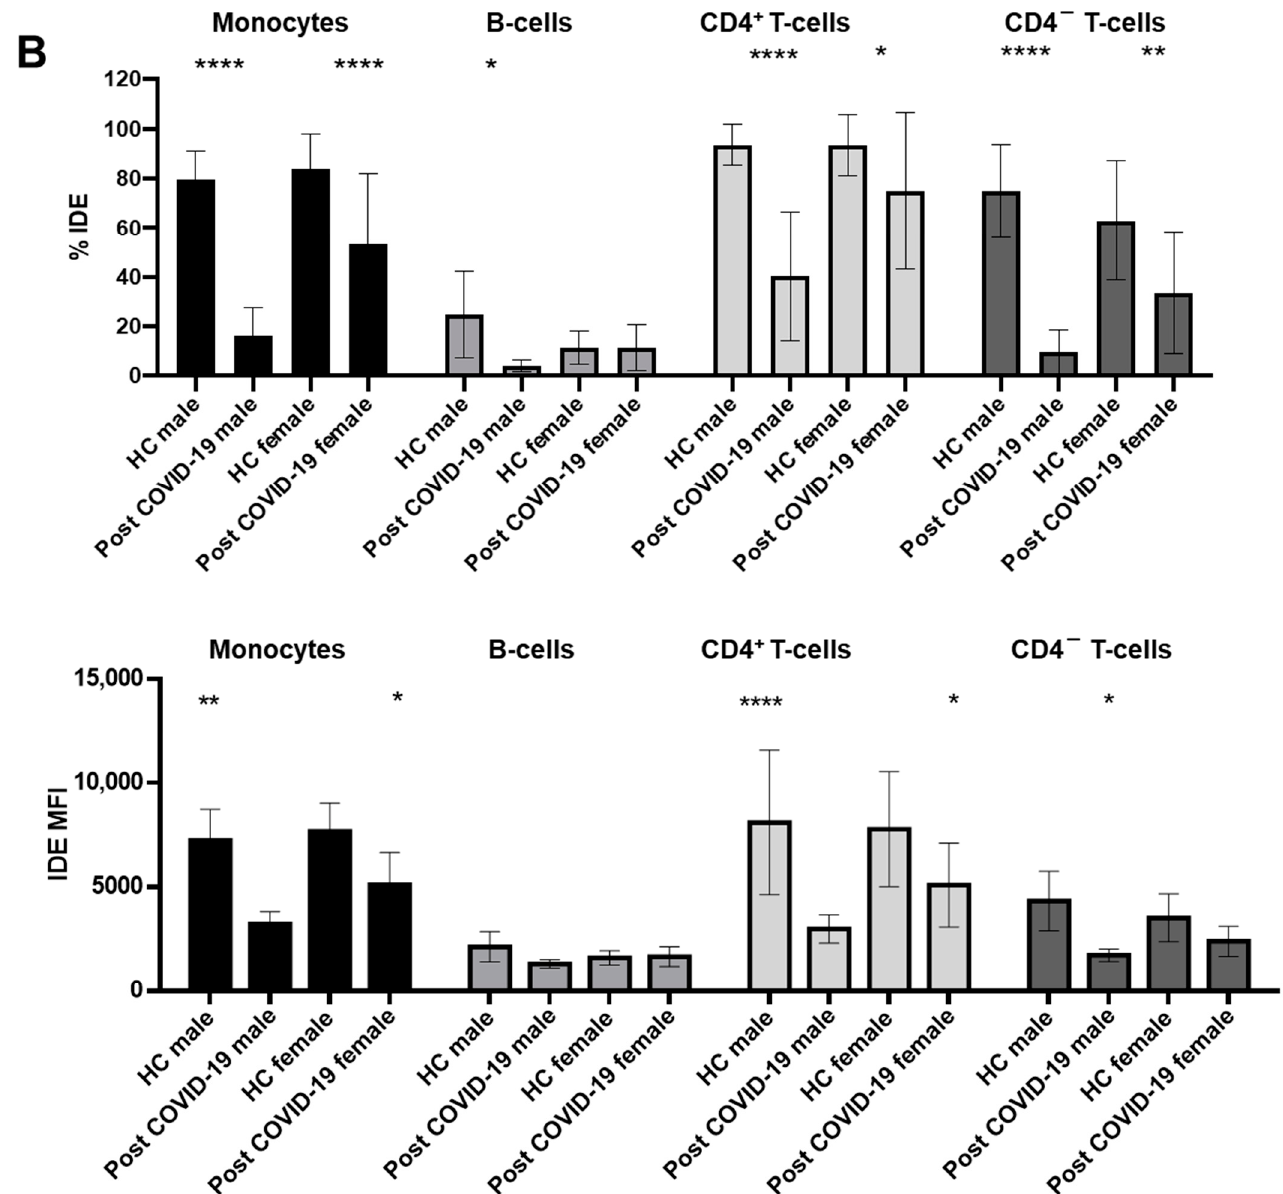
Figure 4. Gender influences IDE surface expression on peripheral blood mononuclear cells from post-COVID-19 patients. ( A ) The percentages and the median fluorescence indexes (MFI) of IDE expression on the monocytes, B-cells, CD4 + T-cells, and CD4 − T-cells of COVID-19 patients 3 months after hospital discharge (post-COVID-19), discriminating between males and females, was determined as seen in Figure 2. ( B ) IDE expression was also determined in male and female healthy controls (HC) compared to post-COVID-19 male and female patients, respectively. Two-way ANOVA with a Sidak correction was applied in Figure 4A, while two-way ANOVA with a Tukey correction was applied in Figure 4B. * p < 0.05; ** p < 0.01; *** p < 0.001; **** p < 0.0001.